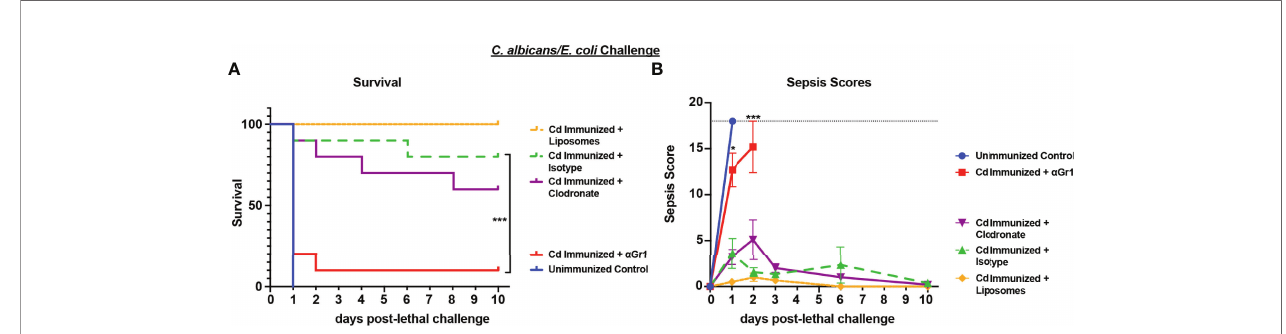
FIGURE 2 | Role of macrophages and Gr-1+ leukocytes in C. dubliniensis -induced protection against polymicrobial C. albicans / E. coli IAI. Mice (n = 10/group) were immunized by i.p. injection with 1.75x10 7 CFUs of live C. dubliniensis 14 days prior to lethal challenge. For macrophage depletion, mice were injected i.p. with liposome-encapsulated clodronate or control empty liposomes 1 day prior to lethal challenge. For Gr-1+ cell depletion, mice were injected i.p. with 200 m g anti-Gr-1 or isotype control antibody 48 h prior to and 2 h after lethal challenge. Mice were challenged with C. albicans (1.75x10 7 CFUs) and E. coli (4.5x10 6 CFUs) i.p. and monitored for (A) survival and (B) morbidity/sepsis scoring for 10 days post-lethal challenge. Naïve (unvaccinated) mice served as the negative control. Graphs are representative of 2 separate experiments. *, P<0.05; **, P<0.01; ***, P<0.001; ****, P<0.0001 [for values signi fi cantly different from those of the control, by log rank Mantel-Cox test (survival) and ANOVA followed by post hoc Student ’ s t-test (sepsis